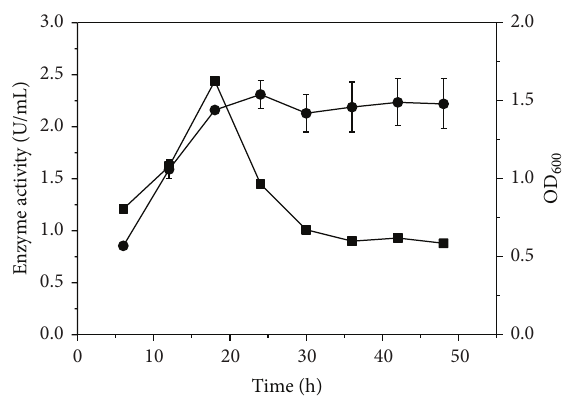
Figure 3: Influence of initial pH on xanthan lyase production by Microbacterium sp. XT11 cultured in the xanthan medium at 30 ∘ C and 150rpm.